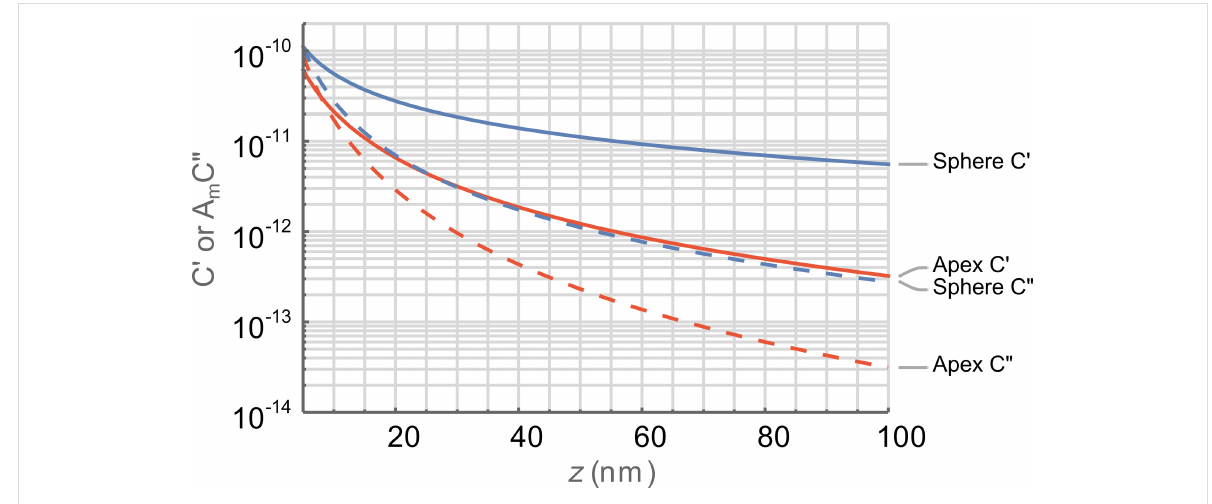
Figure 1: Comparison of apex and sphere capacitance functions as a function of the tip–sample separation, z . C ′ Apex (red), A m C ″ Apex (red dashed), C ′ Sphere (blue), and A m C ″ Sphere (blue dashed). Higher is